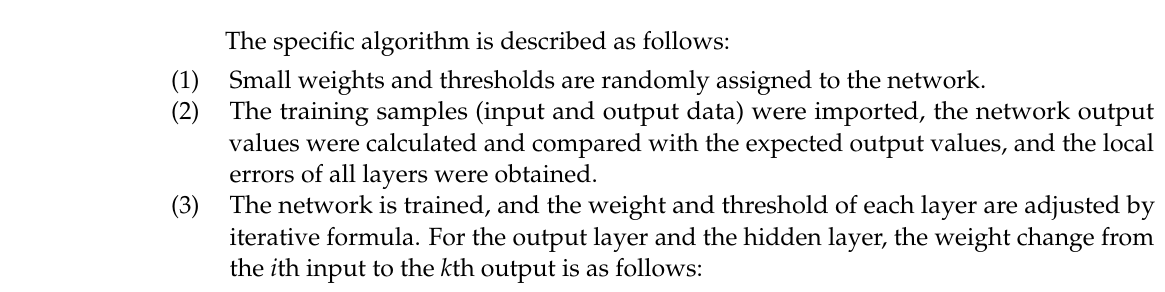
Figure 2. Flow chart of the BP neural network algorithm for ma tt e grade.